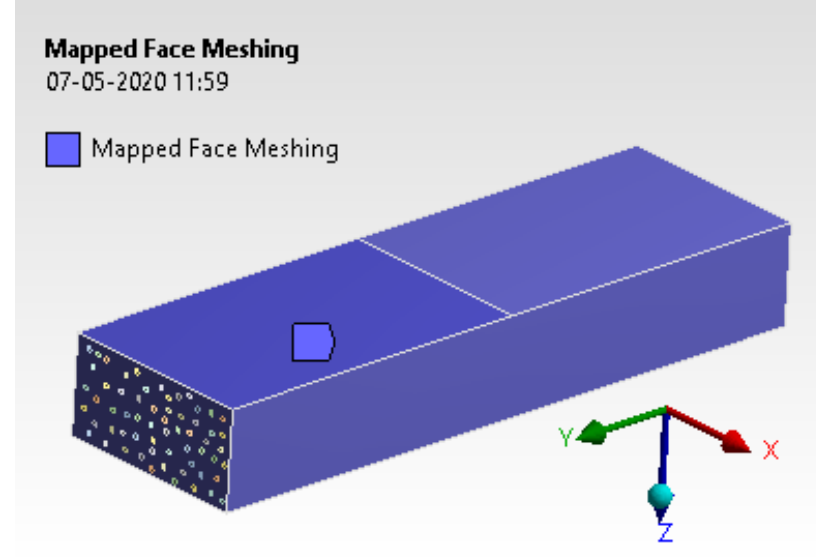
Figure 12. Mapped face meshing.